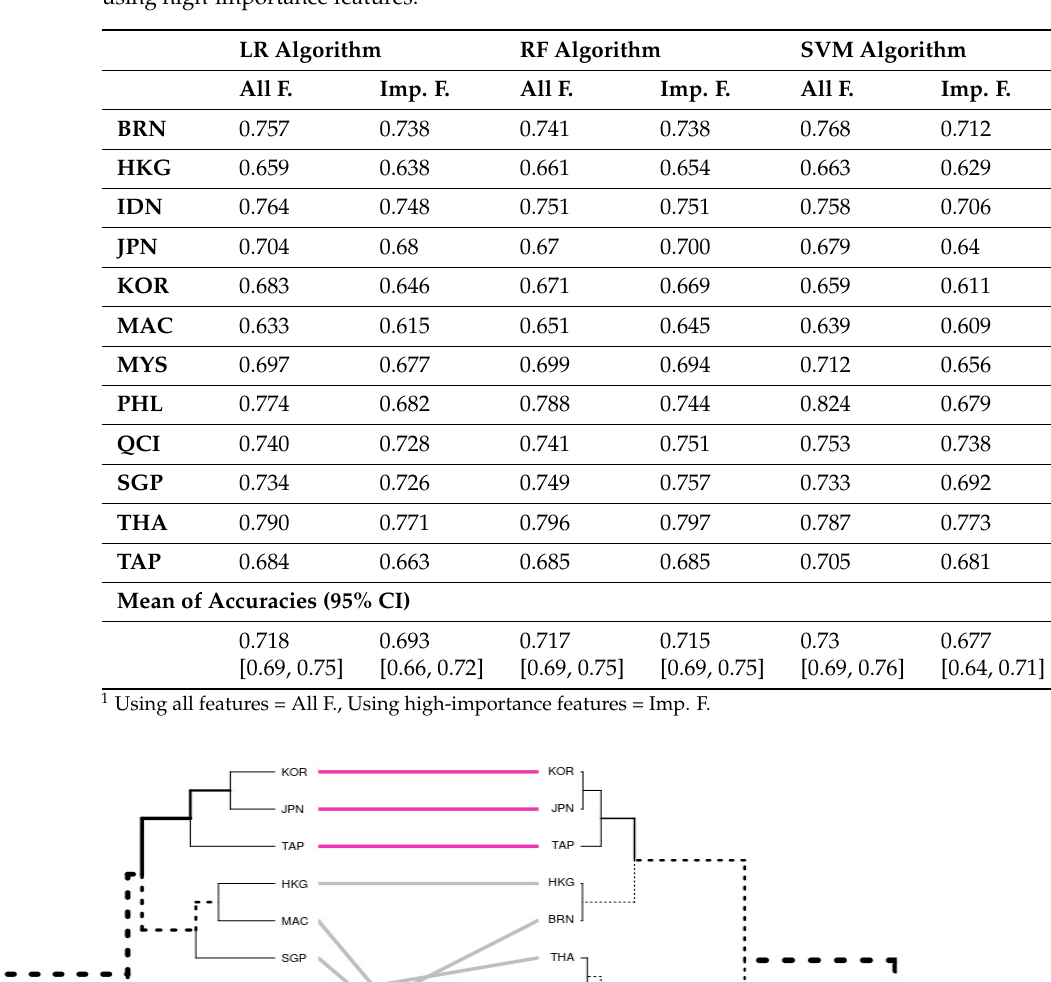
Table 7. Comparison of the performance of models created using all features and models created using high-importance features.